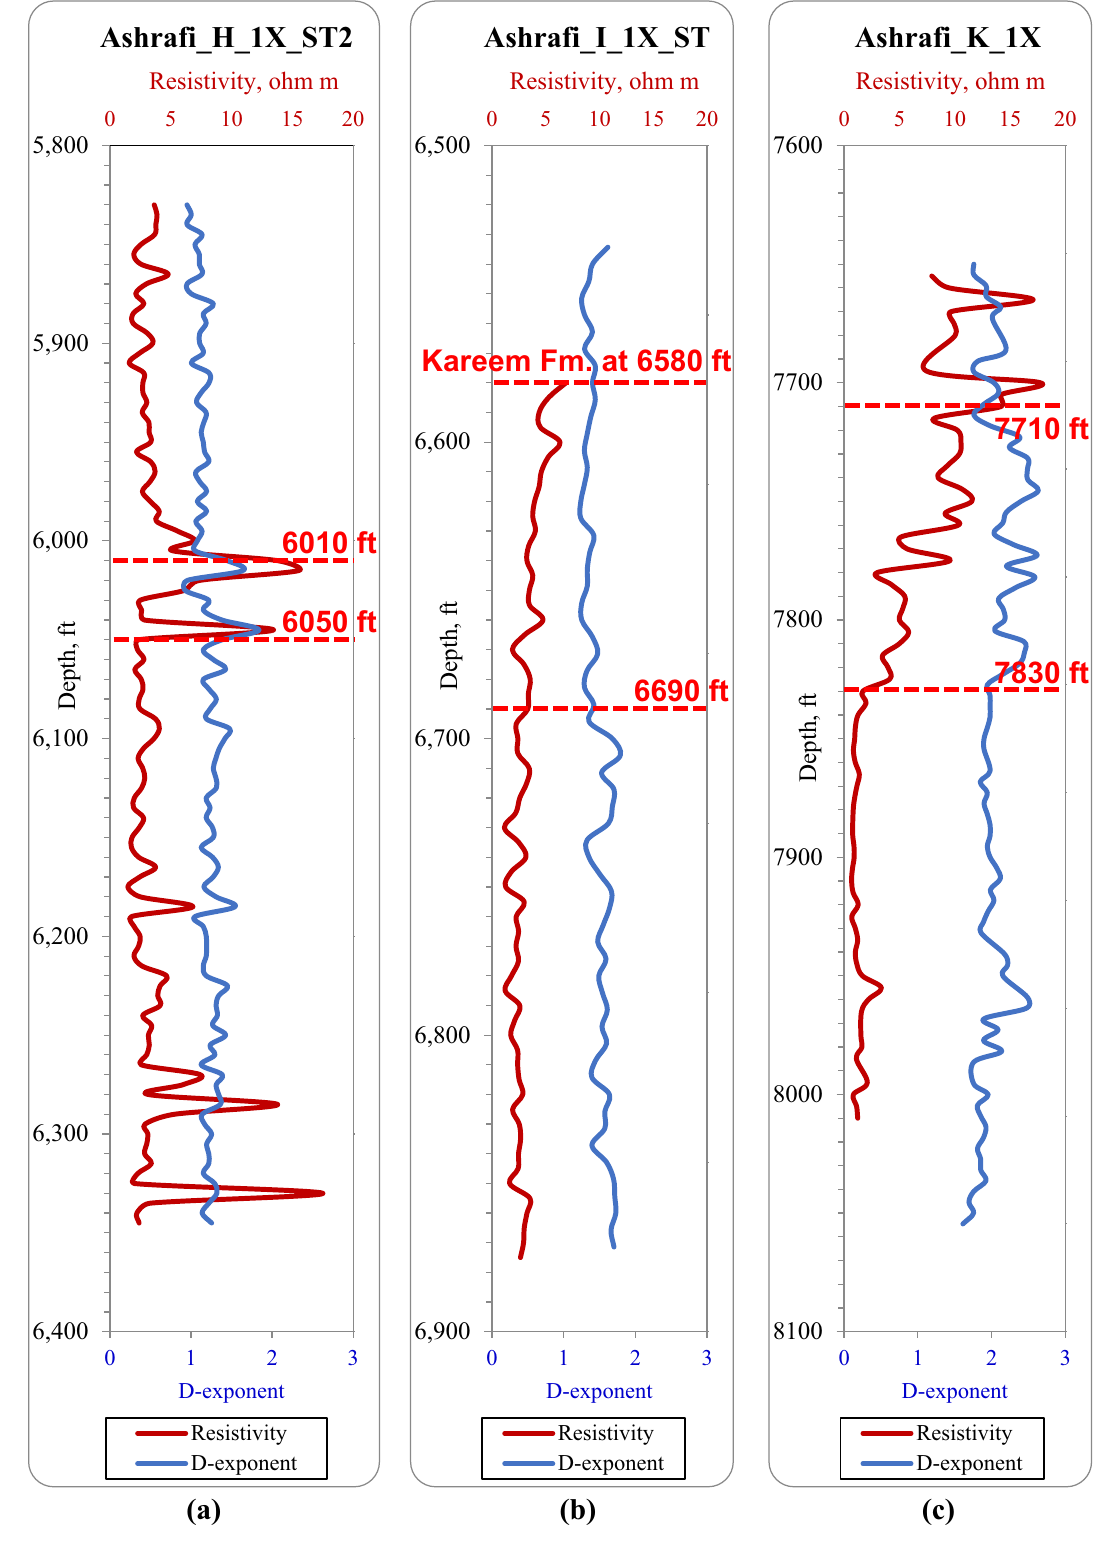
Fig. 5 D -exponent and resistivity log with depth relationship. a Ashrafi_H_1X_ST2, b Ashrafi_I_1X_ST, and c Ashrafi_K_1X. The red dashed lines represent the possible overpressure